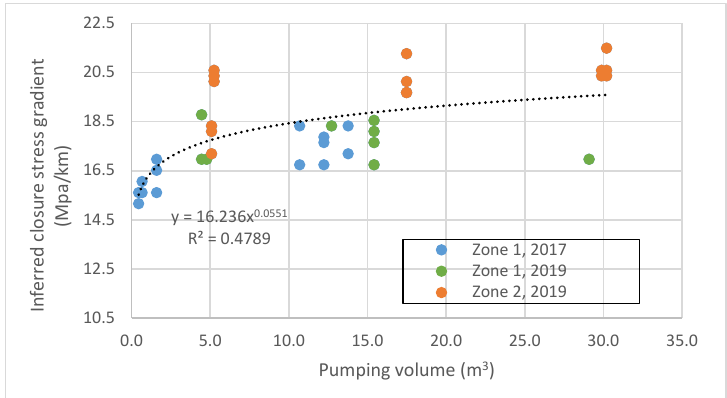
Figure 17. Inferred closure stress vs. pumping volume.